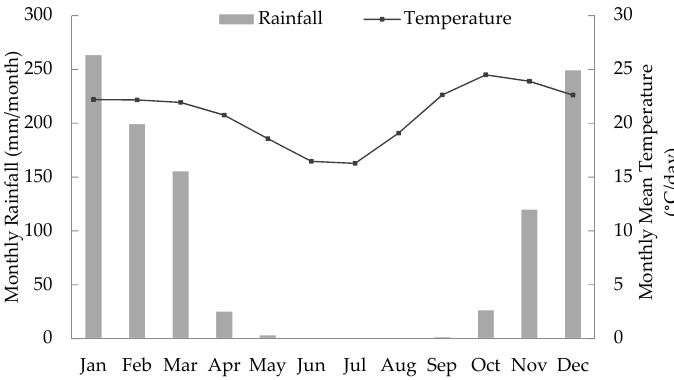
Figure 2. Regional mean monthly precipitation and temperature from 1984 to 2013.